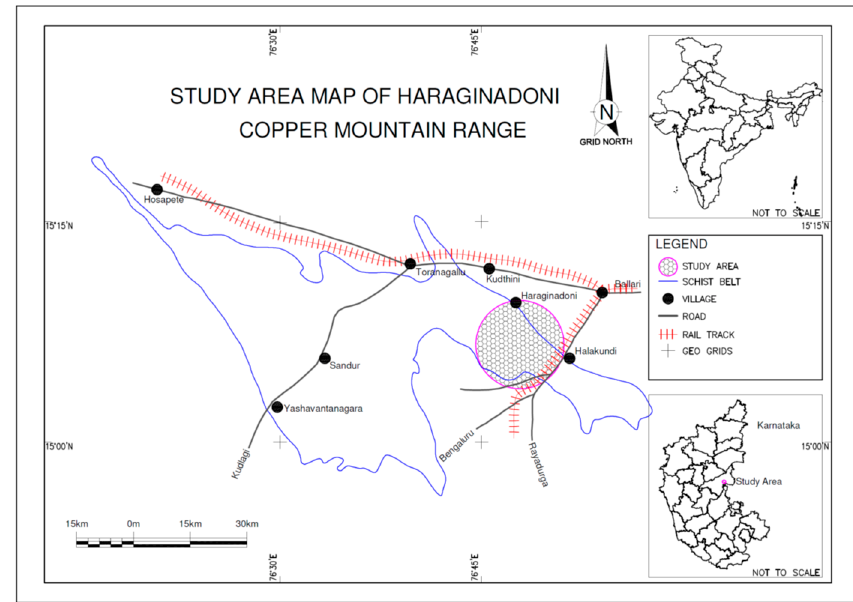
Figure 1. Location of the study area of Haraginadoni.